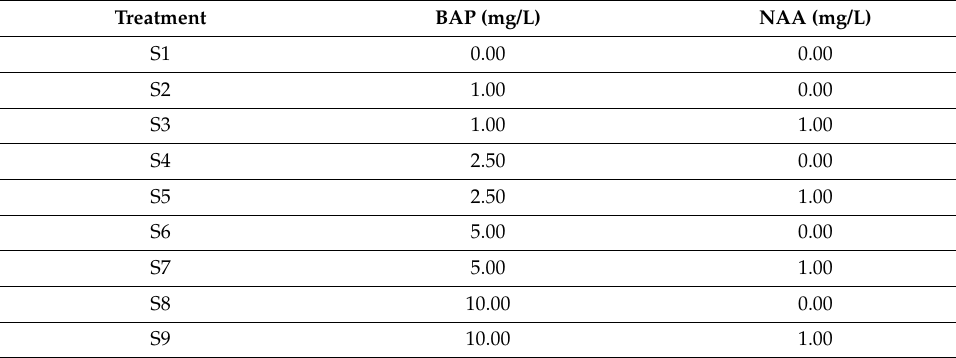
Table 2. Plant growth hormones added in MS media used for shoot regeneration of stevia through in vitro